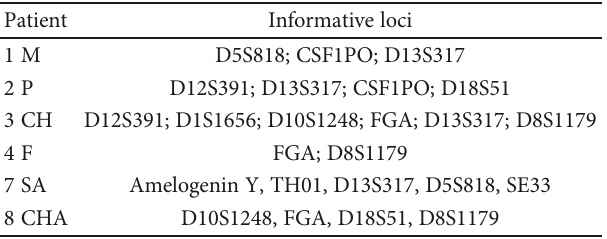
Table 3: The informative loci for chimerism analysis.